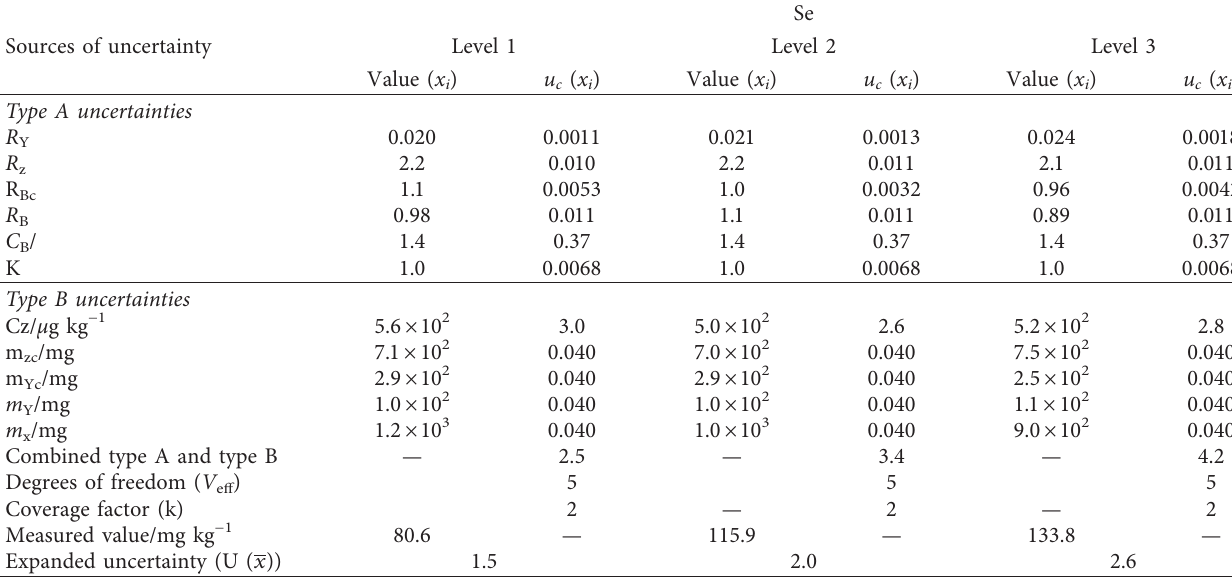
Table 6: Sources of uncertainty in the determination of